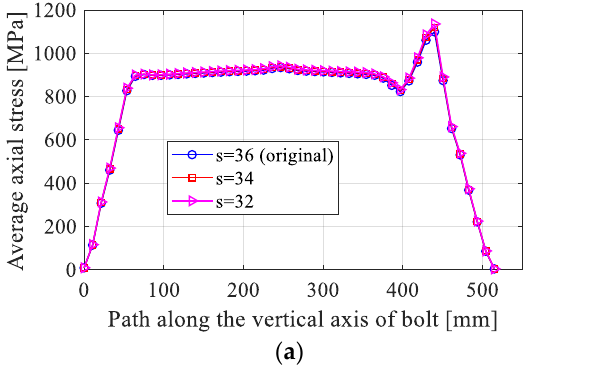
Figure 9. Influence of shell thickness on stress distributions: ( a ) bolt and ( b ) flange.